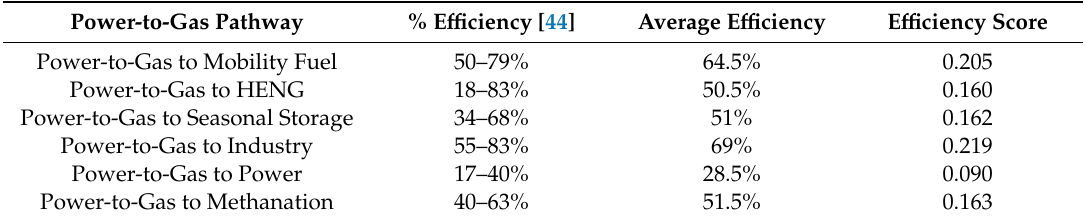
Table 6. E ffi ciency of power-to-gas Pathways—E ffi ciency Score.